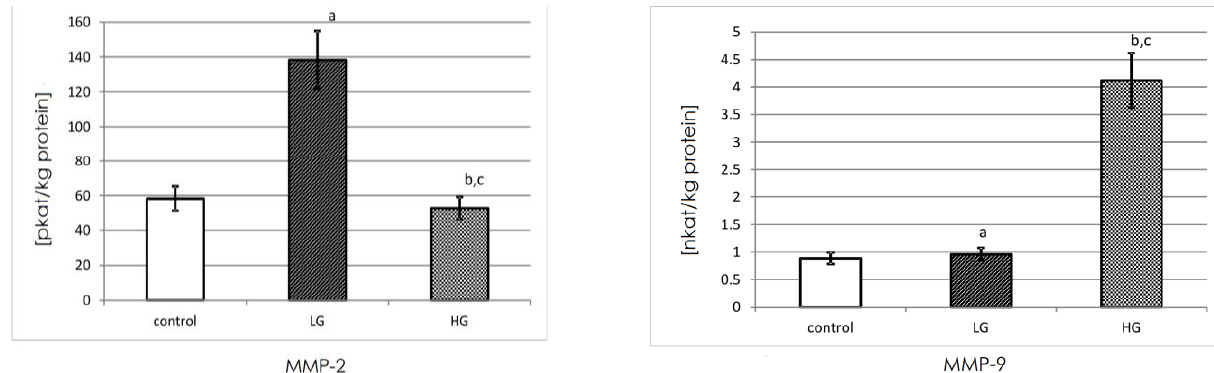
Figure 5. MMP-2 and MMP-9 actual activity in control tissue ( n = 10) and low-grade (LG) ( n = 10) and high-grade (HG) ( n = 10) urinary bladder cancer. a — p < 0.001 low-grade cancer vs. urinary bladder control; b — p < 0.05 high-grade cancer vs. urinary bladder control; c — p < 0.001 high-grade vs. low-grade urinary bladder cancer.